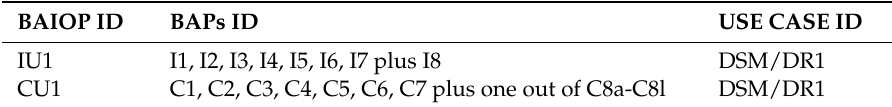
Table 9. BAIOPs and respective